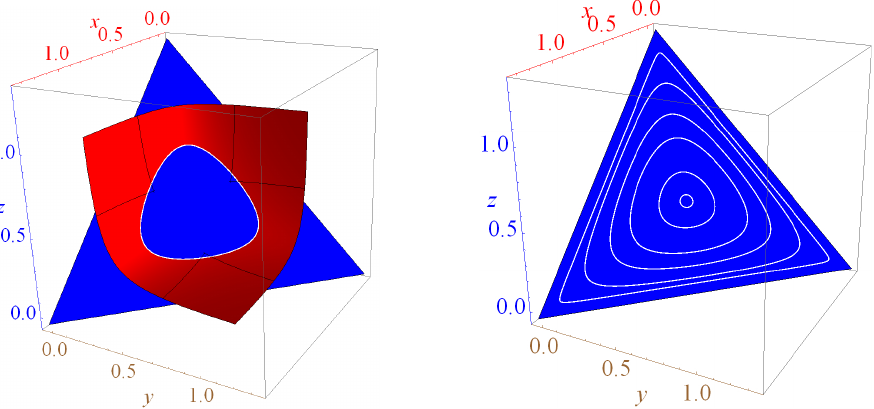
Figure 2. Left : The intersection of level sets: a periodic orbit. Right : A local foliation of the level set S h = { ( x , y , z ) ∈ R 3 : x + y + z = h , x , y , z ≥ 0 } by periodic orbits around the stable equilibrium ( ah ) , bh , ch a + b + c a + b + c a + b + c